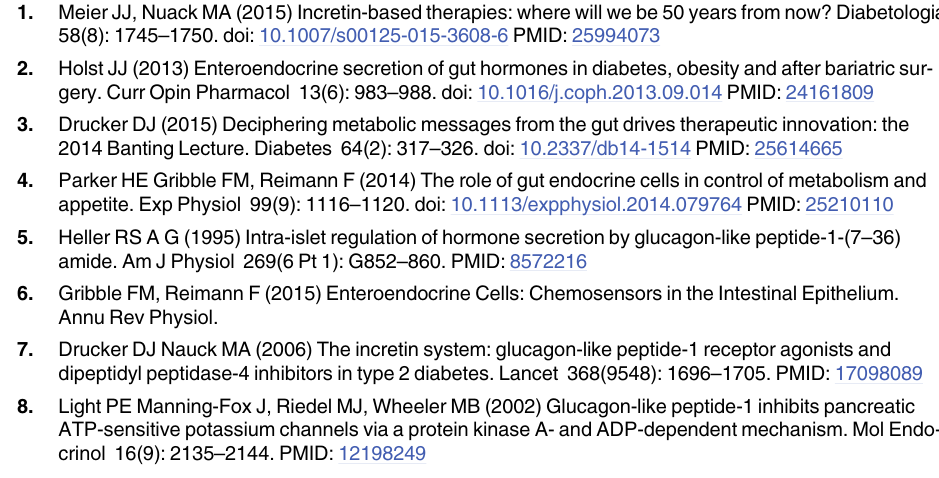
S1 Fig. AMPK expression is unaffected in β -cells from iGluAMPKdKO mice. S2 Fig. Ampk α 1 and - α 2 gene expression in purified L-cells and control non-fluorescent cells from the upper small intestine, lower small intestine and colon. S1 File. Supplementary Figure